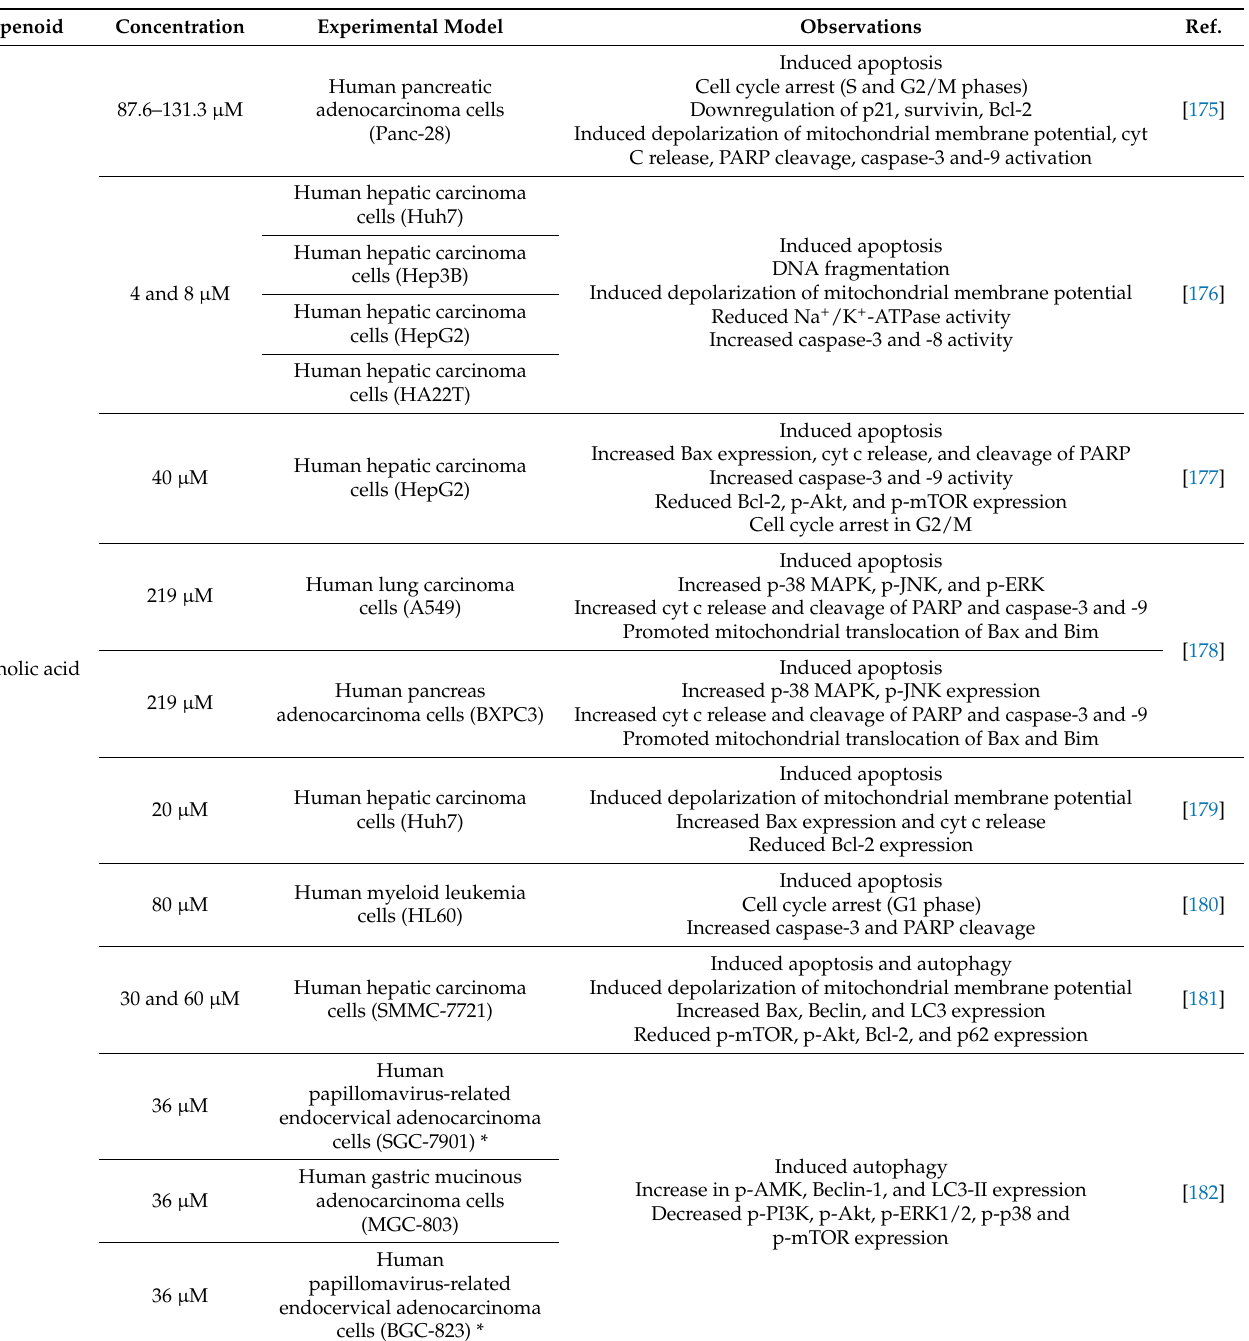
Table 5. Cell death modulation by oleanolic and ursolic acids in in vitro and in vivo animal experi- mental